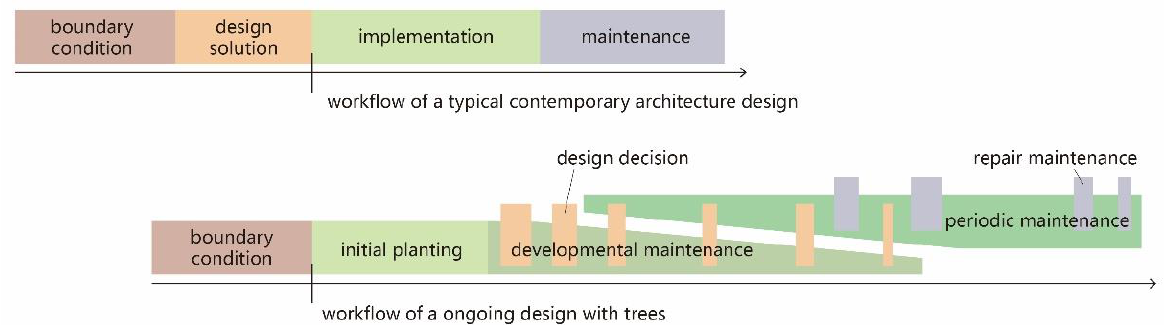
Figure 2. Proposed workflow for a dynamic design to deal with tree growth and death. Unlike a contemporary architecture design (shown on the top ), the design decision (see dark orange rectangles) in the new workflow will no longer be made only once but multiple times through the tree’s life cycle (shown on the bottom ).